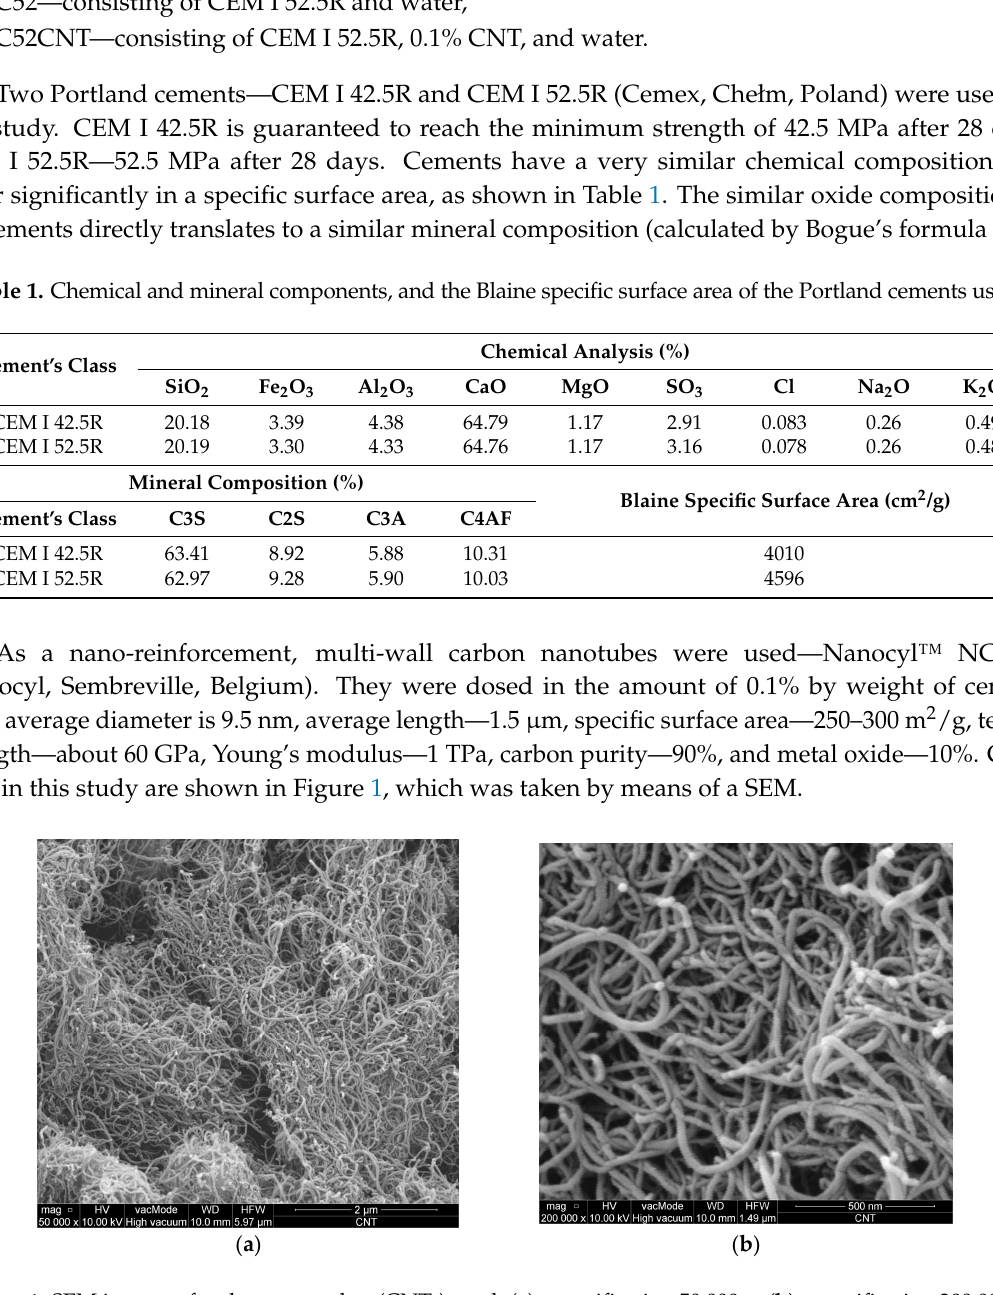
Figure 1. SEM images of carbon nanotubes (CNTs) used: ( a ) magnification 50,000×; ( b ) magnification 200,000×.